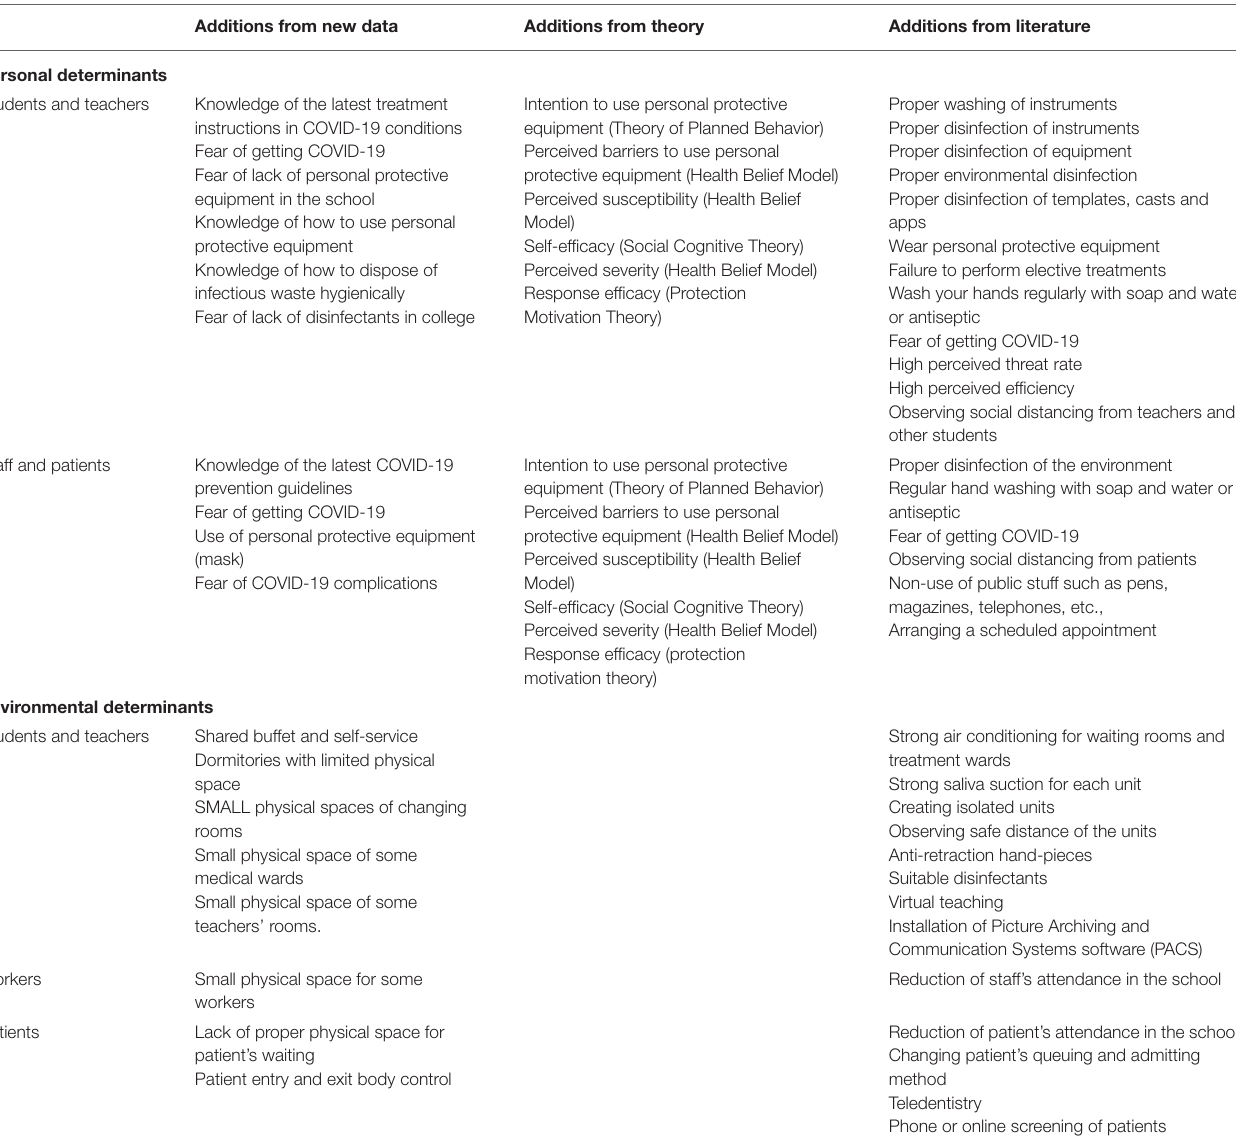
TABLE 1 | Identifying determinants being affected by COVID-19 in the school of